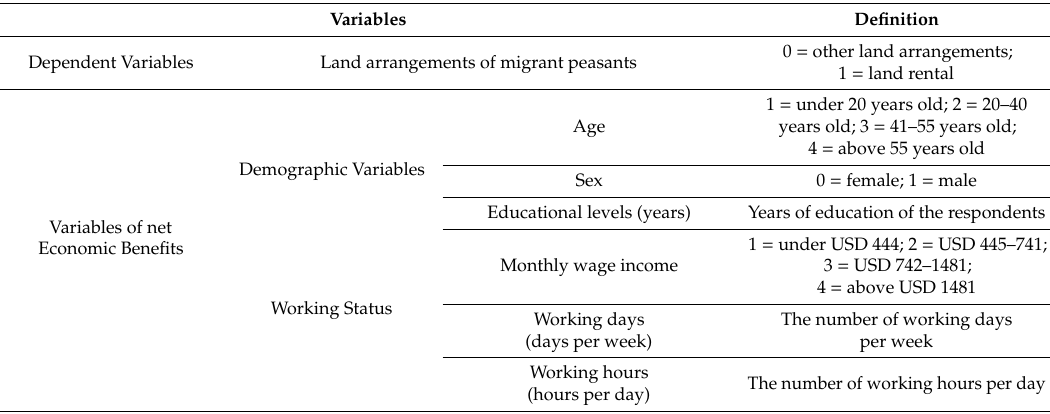
Table 1. Variable